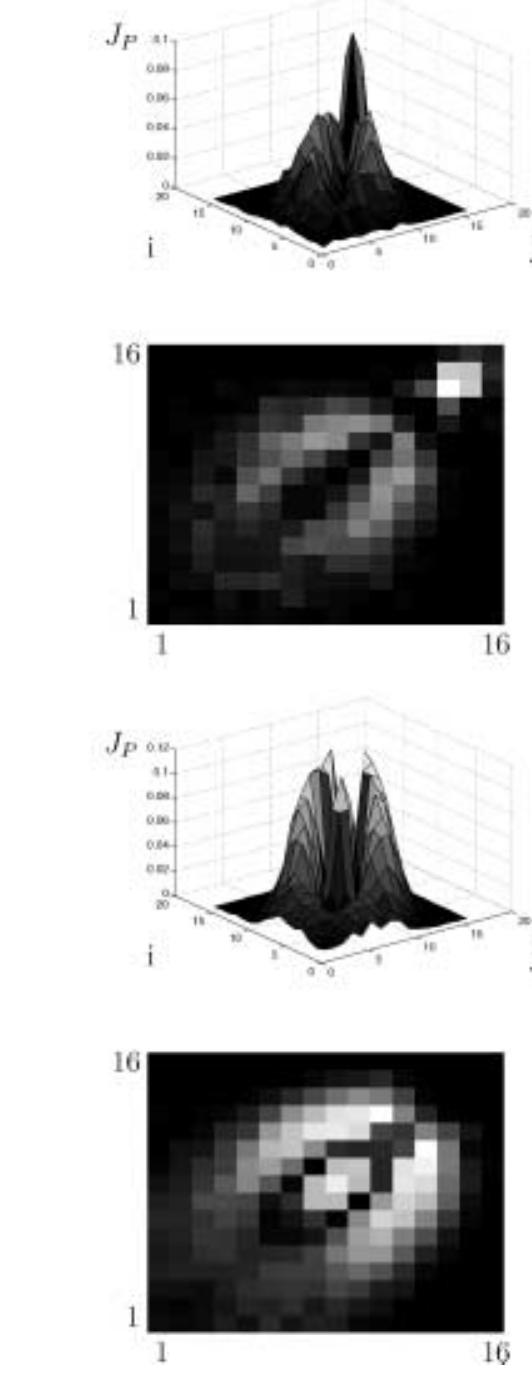
Fig. 5. Left: The GLCM Class Difference Matrix, ∆ P ( i , j | ω 1 , ω 2 ), computed from the peripheral 30% (upper) and the central 70% (lower) 1D segments of nuclei from monolayers. The positive values in the surface plots (and the lighter areas in the gray-scale plots) correspond to matrix elements that are more probable for the good prognosis class than for the bad prognosis class. Right: The Mahalanobis Class Distance Matrix, J P ( i , j | ω 1 , ω 2 ), between the good and bad prognosis classes, based on the GLCM matrices, computed from the peripheral 30% (upper) and the central 70% (lower)